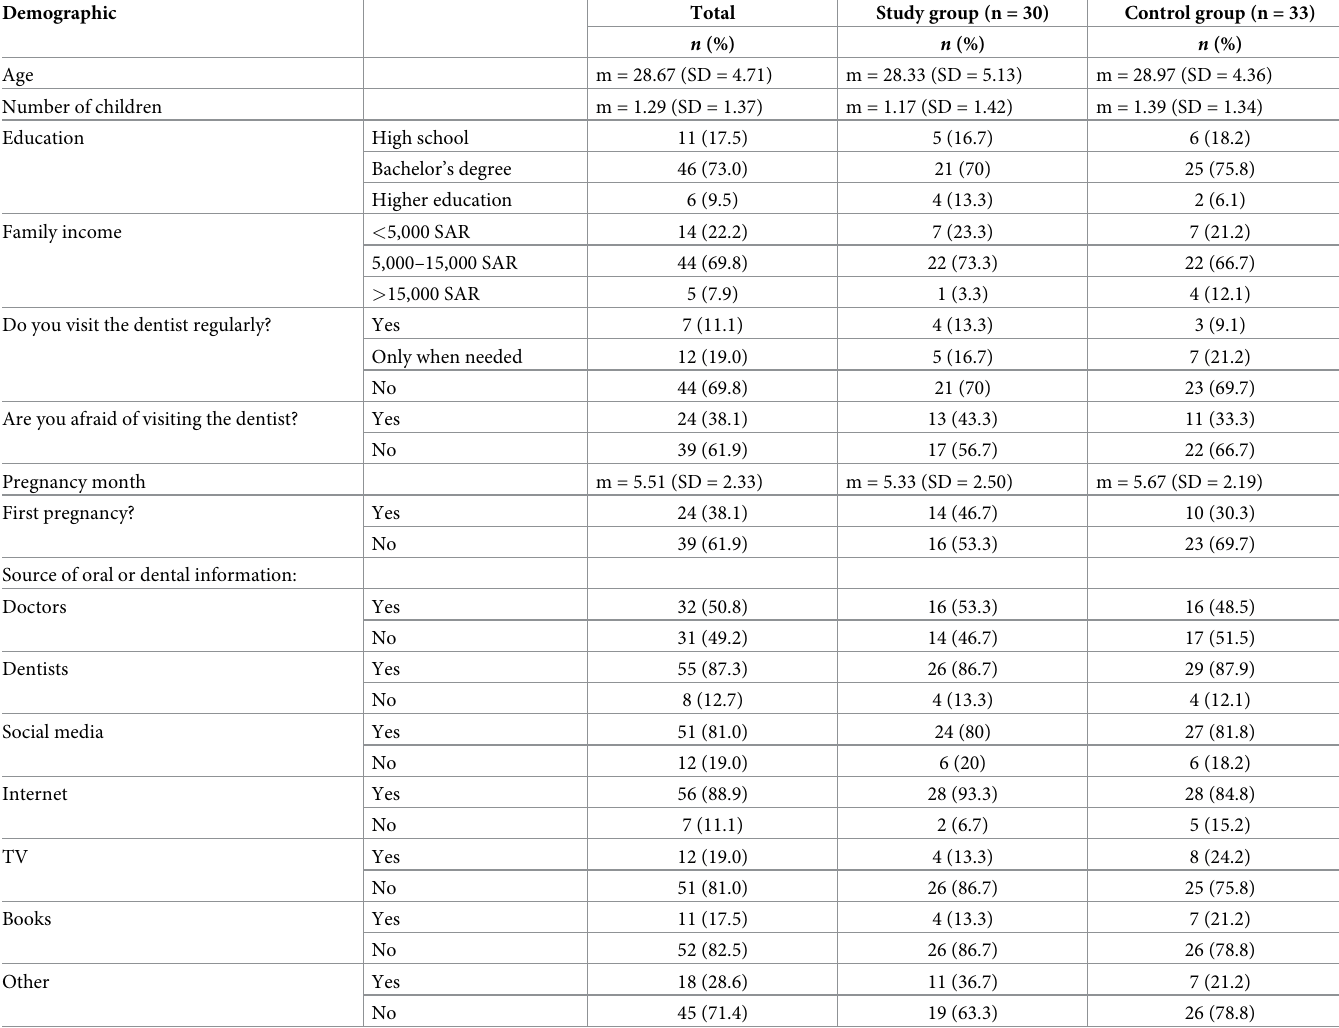
Table 2. Demographic variables of the pregnant women in this